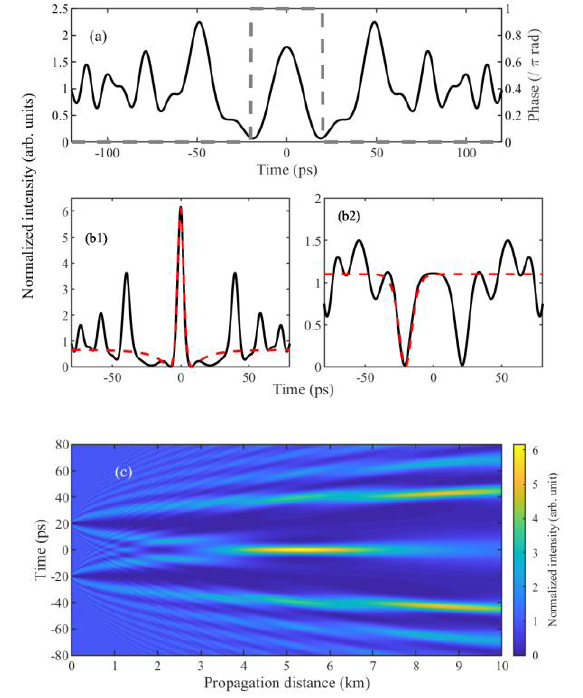
Fig. 2. (a) Initial phase profile (dashed line) and output intensity profile in the linear propagation. (b) Temporal intensity profiles in presence of nonlinearity observed after 5.37 km in a fiber with anomalous dispersion (b1) or after 10 km in a fiber with normal dispersion (b2) for an initial power of 290 mW. The red dashed lines are the profiles of a Peregrine soliton at its point of maximum focusing and of a black soliton. (c) Longitudinal evolution of the intensity profile in the anomalous regime of dispersion.